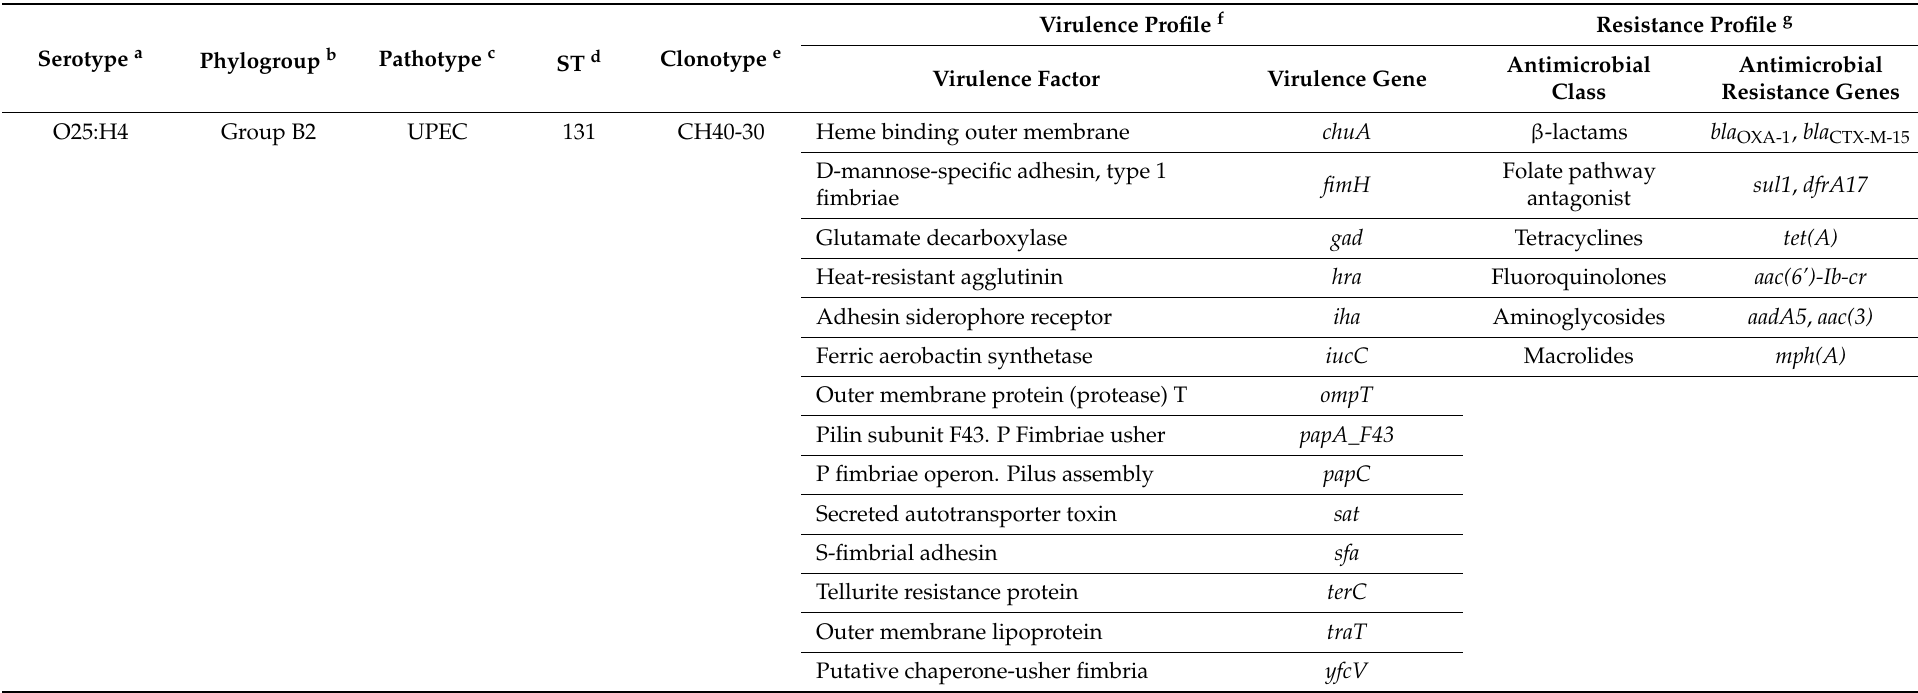
Table 2. Molecular typing, resistance profile, and virulence genes encoded by the genome of UPEC isolate EC14142 from